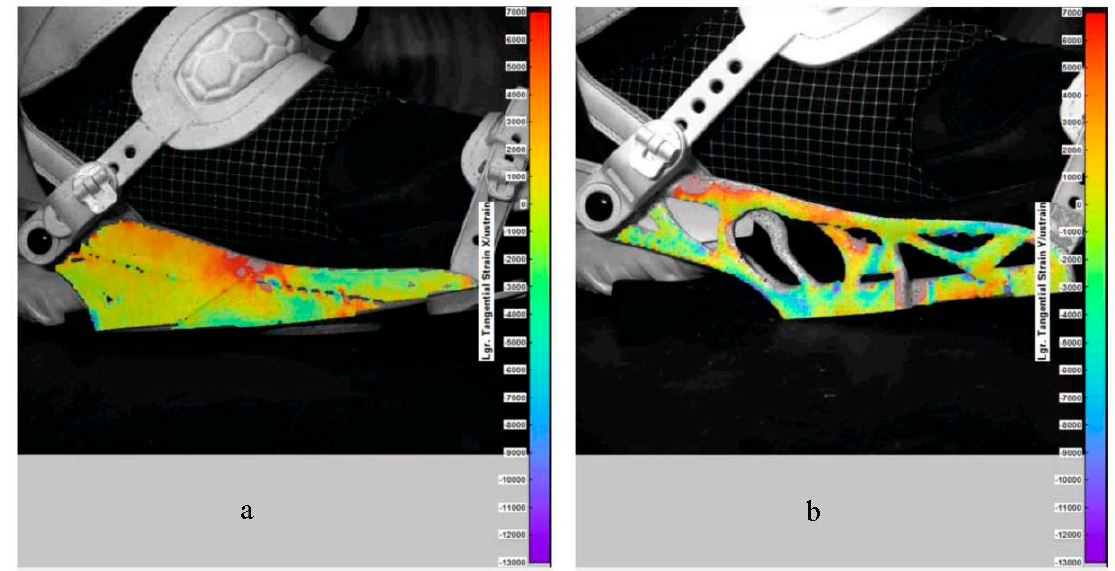
Figure 9. DIC comparison of deformations (horizonal axis) in plantarflexion of the commercial binding ( a ) and of the prototype ( b